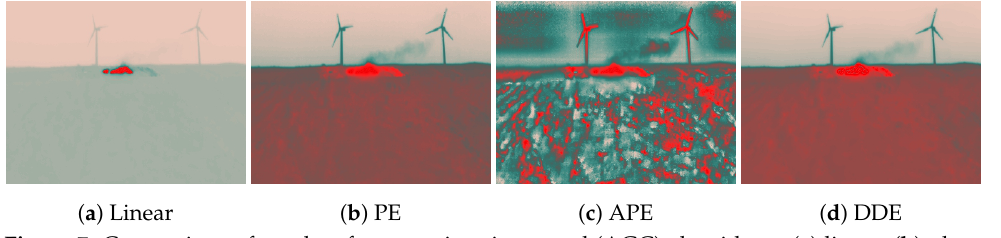
Figure 7. Comparison of results of automatic gain control (AGC) algorithms: ( a ) linear, ( b ) plateau equalization (PE), ( c ) advanced plateau equalization (APE), and ( d ) digital detail enhancement